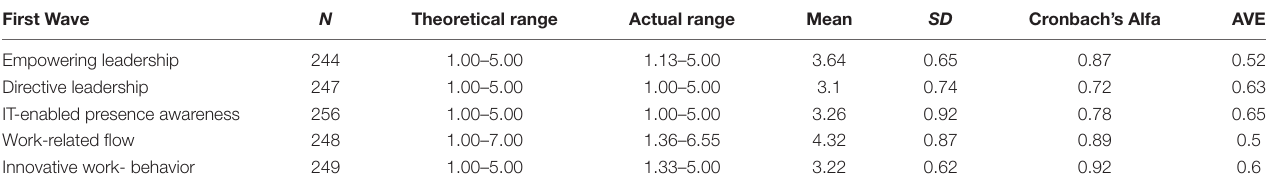
TABLE 2 | Construct descriptive statistics First Wave.